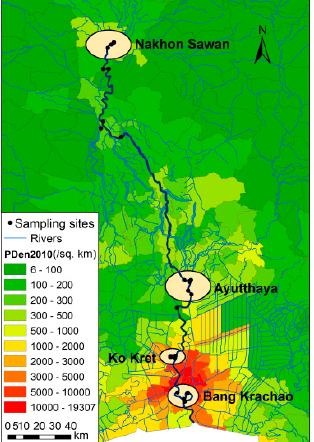
Figure 1. Four targeted river reaches for survey in the present study (PDen2010: Population Density in Thailand in 2010. Source: National Statistical Office, Thailand).